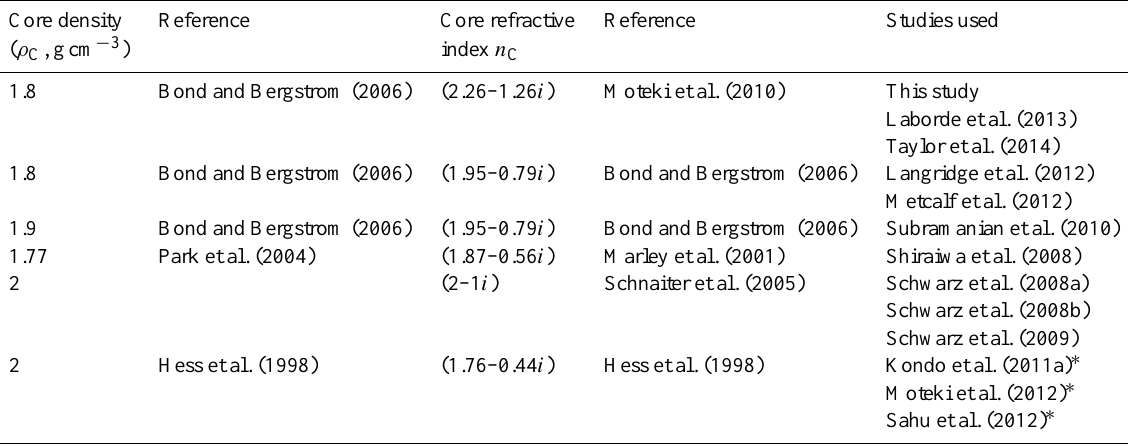
Table 1. Summary of core densities and refractive indices used in previous SP2 core / shell calculations.